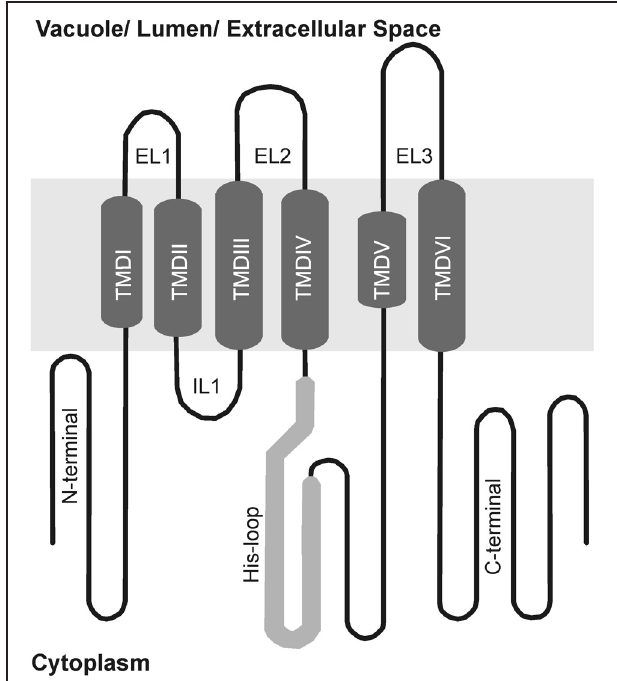
FIGURE 3 | Schematic membrane topology model of group 1 MTP proteins. Predicted transmembrane domains (TMDs) in the center (I to VI), cytoplasmic loops below and vacuolar loops above. His-loop, histidine rich loop; IL, intracytosolic loop; EL, extracytosolic